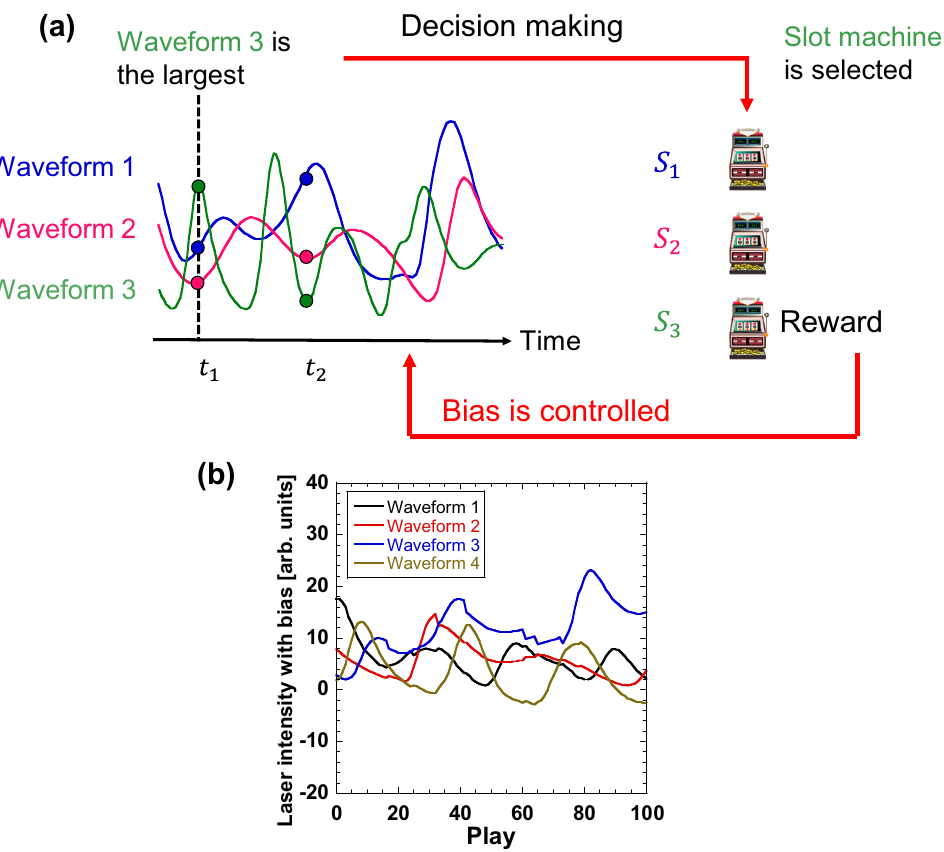
Figure 1. Decision-making method using chaotic temporal waveforms with bias control. ( a ) Schematic diagram. ( b ) Chaotic temporal waveforms assigned to slot machines ( N =